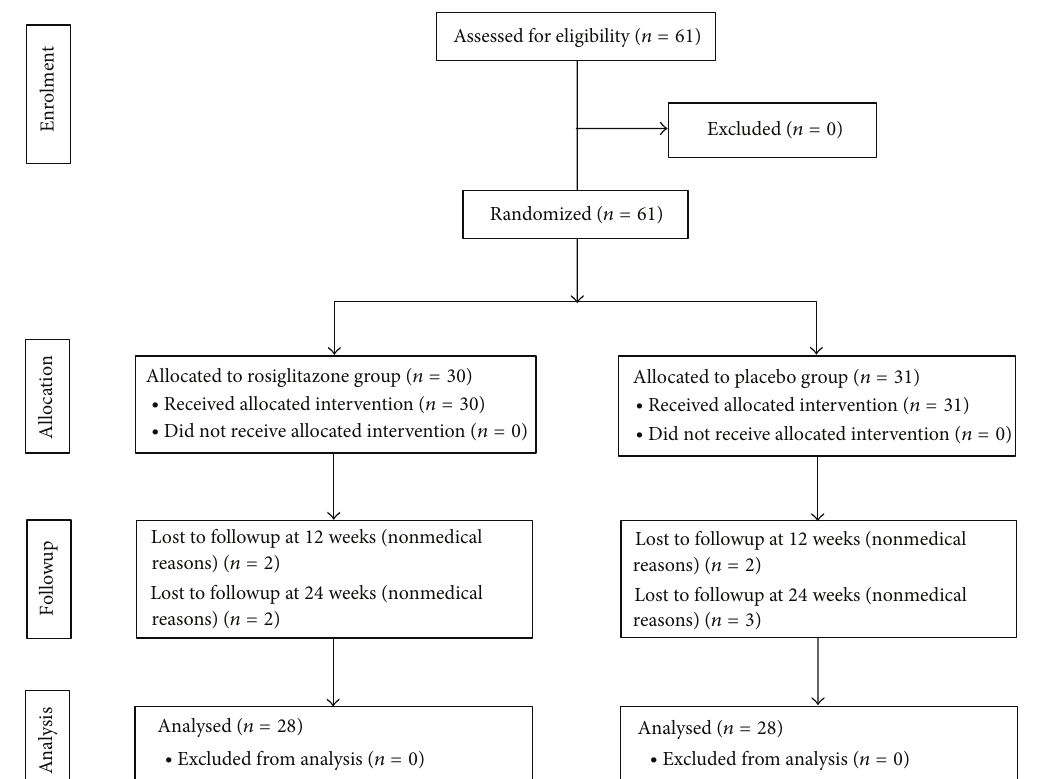
Figure 1: Flowchart of the study